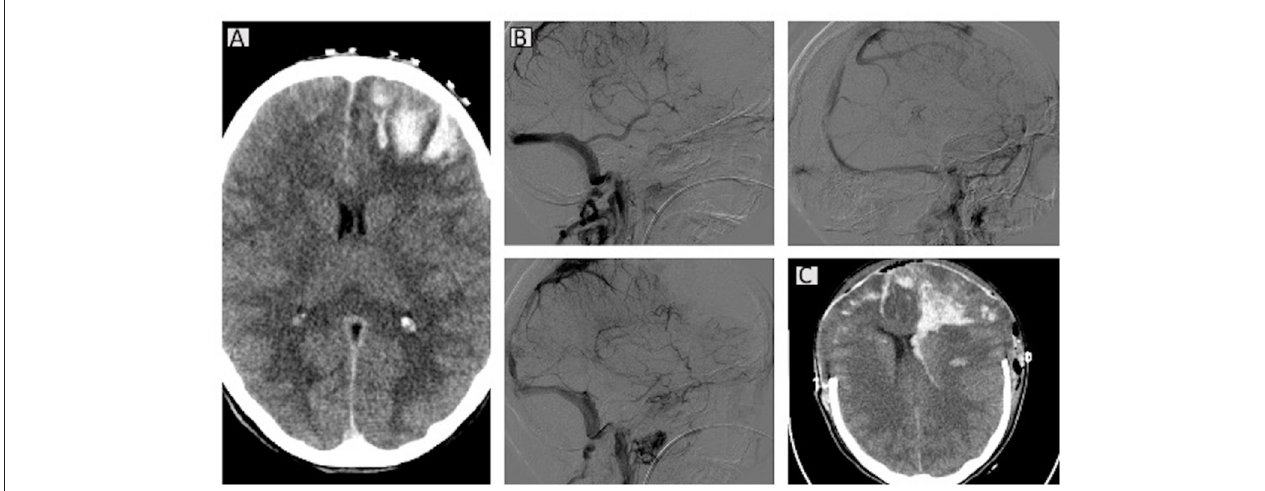
FIGURE 2 | Computed tomography (CT) scans for case 2. A brain CT scan showed bilateral venous infarct with hematic component in the fronto-basal-anterior and parietal areas and associated intraventricular hemorrhage. Initial cerebral herniation of the cerebellar tonsils is present (A) . At angio-CT, the arterial circulation is patent, whereas the superior sagittal sinus appears obliterated, the sinus recto is thinner, and the cavernous sinus is partially matted (B) . Bilateral decompressive craniectomy and midline shift are evident in the latest CT scan (C)